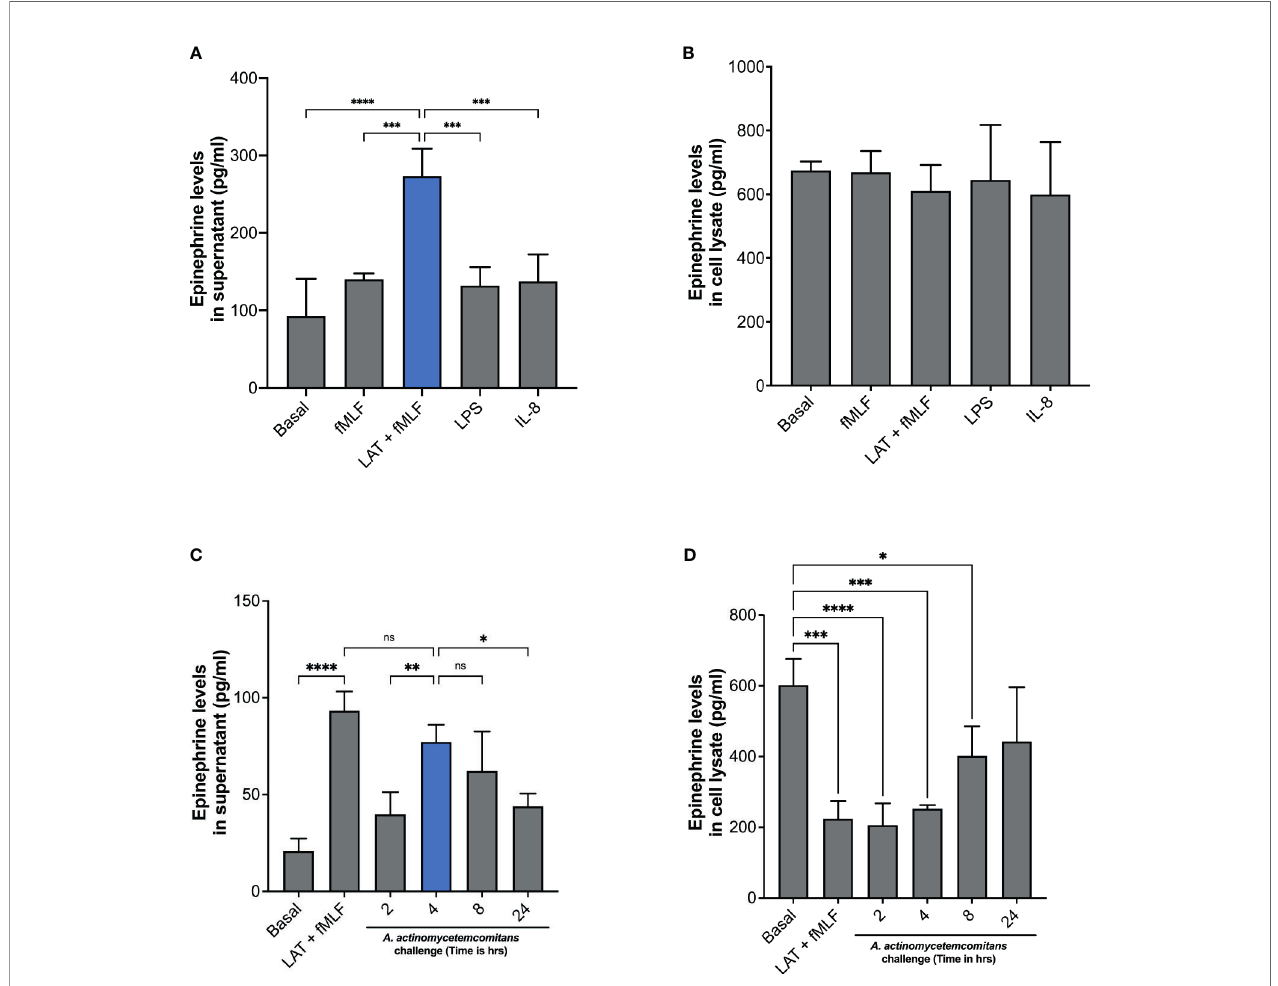
FIGURE 1 | Human neutrophils release epinephrine upon A . actinomycetemcomitans challenge. Human neutrophils (5 × 10 6 cells/ml) were treated with fMLF, Latrunculin A (LAT) + fMLF, LPS, or IL-8 to induce epinephrine release. Epinephrine content was determined in neutrophil supernatant (A) and cell lysate (B) by ELISA. Human neutrophils (3 × 10 6 cells/ml) were challenged with A . actinomycetemcomitans ( Aa ; MOI 50) for 2 h, 4 h, 8 h, and 24 h At the end of each time point, supernatant (C) and cell lysates (D) were collected and epinephrine content was measured by ELISA. Epinephrine concentration is plotted as the mean ± SD of four independent experiments. Statistical differences among experimental conditions and time points were analyzed by one-way ANOVA (A, B) or repeated measures one-way ANOVA (C, D) , followed by Tukey ’ s post-test. ns, not signi fi cant, * p < 0.05, ** p < 0.01, *** p < 0.001, **** p <